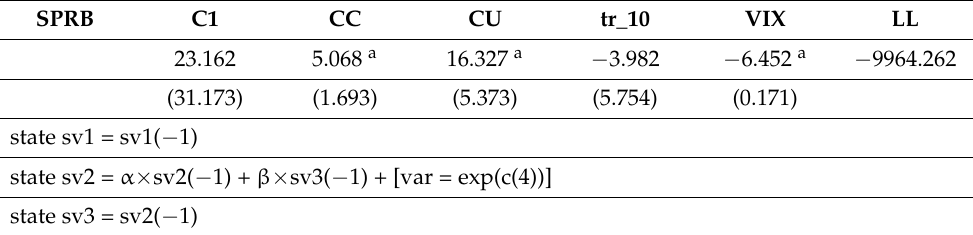
Table 2. Kalman filter estimation of Equation (1).